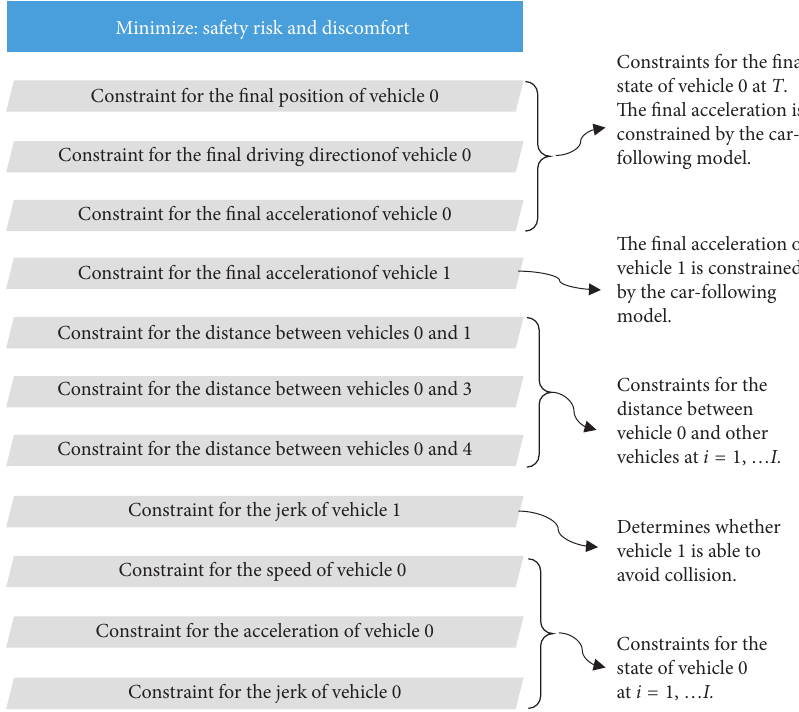
Figure 2: The outline of the proposed nonlinear